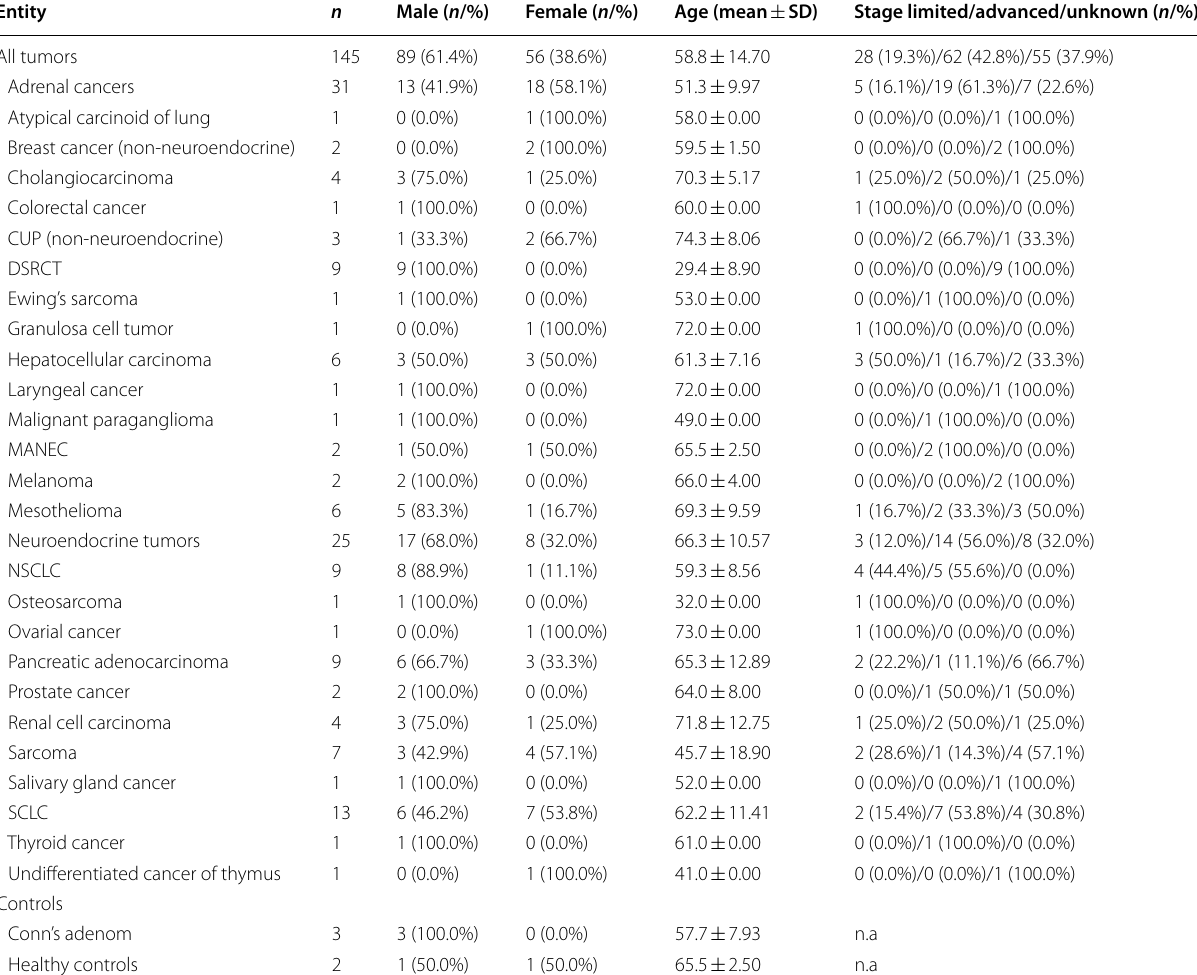
Table 1 Primary characteristics of patients and controls